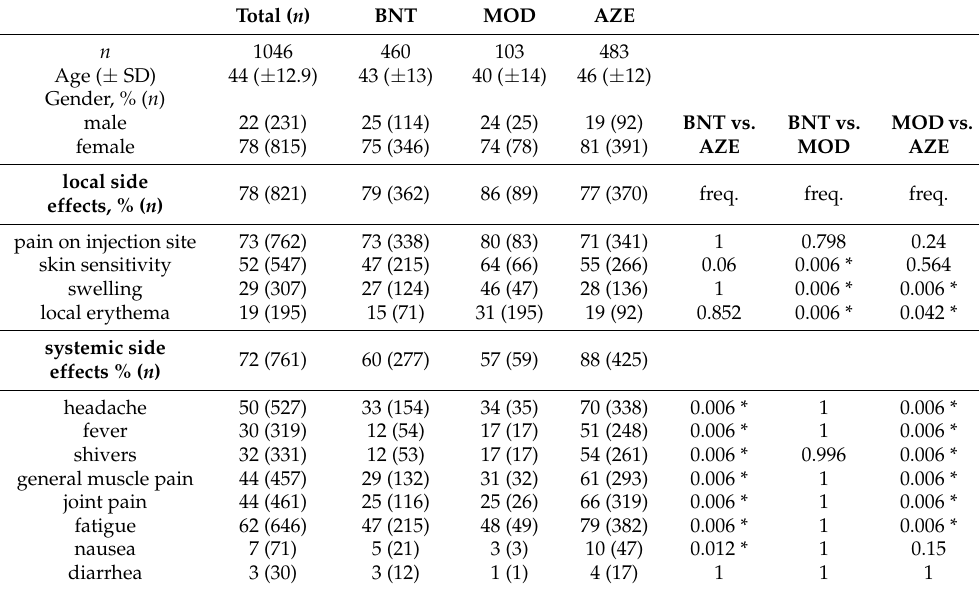
Table 2. Acute local and systemic side effects after the first vaccination. Total ( n )